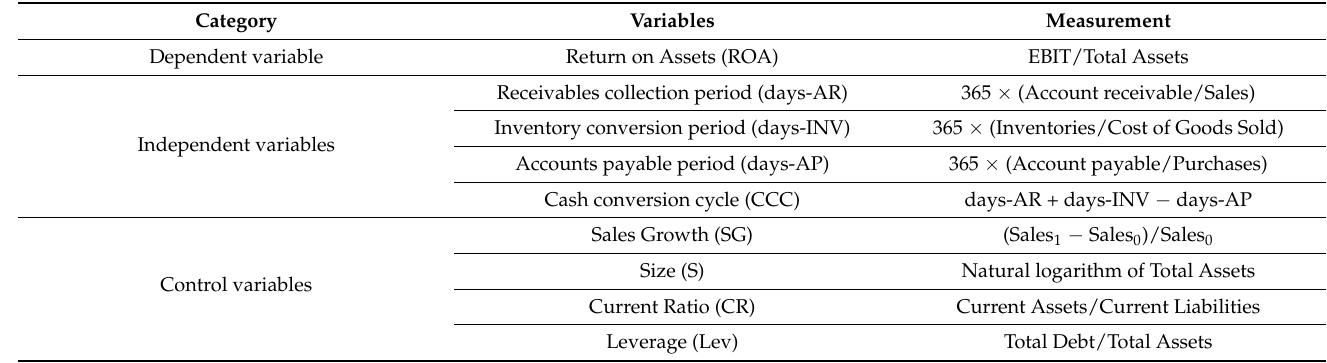
Table 1. Variables and